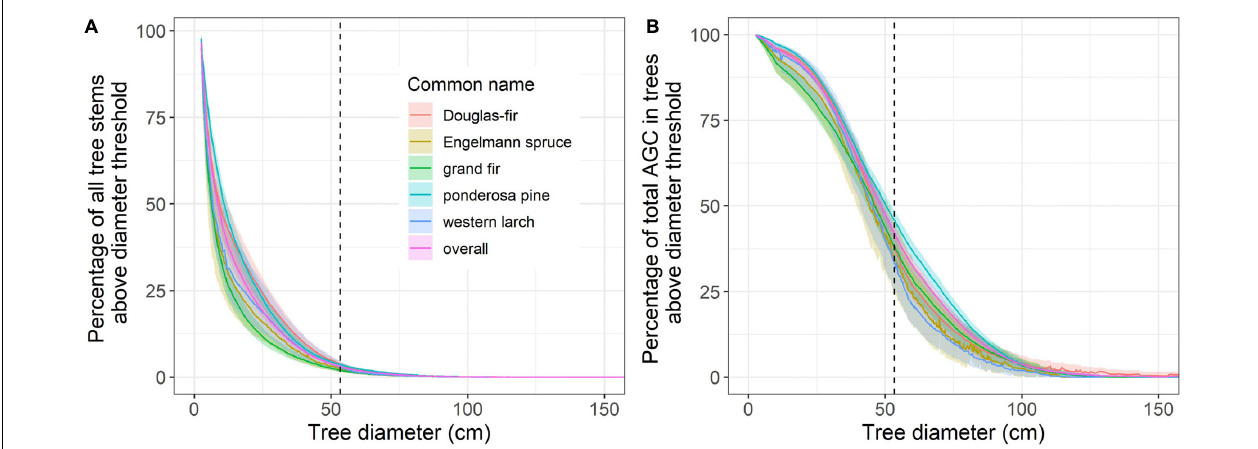
FIGURE 3 | Percentage of (A) all tree stems and (B) total aboveground carbon that occur in trees above a given diameter threshold by species based on measurements from USFS inventory plots located in the six eastside national forests. The dashed vertical lines represent a 21 in (53.3 cm) tree DBH. These estimates and 95% confidence intervals were derived by resampling ( n = 10 4 ) measurements from inventory plots ( n = 3,335). For example, trees with ≥ 21 in diameter represent 3.7 [3.2, 4.2]% of all ponderosa pine and account for 45.8 [42.8, 48.8]% of all aboveground carbon stored by this species on these inventory plots. Only ∼ 0.002% of trees exceeded 150 cm diameter, so for visual clarity we limited the x -axis to 150 cm. TABLE 3 | Percentage of all trees stems and total aboveground carbon (AGC) occurring in trees above and below the 21 in DBH threshold based on measurements from USFS inventory plots located in the six eastside national forests.